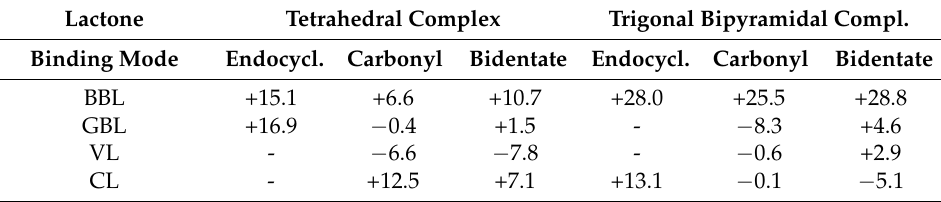
Table 7. Reaction energies ( ∆ G R ) for the substitution of a THF molecule by a lactone. Data in (kJ/mol). Lactone Tetrahedral Complex Trigonal Bipyramidal Compl. Binding Mode Endocycl.